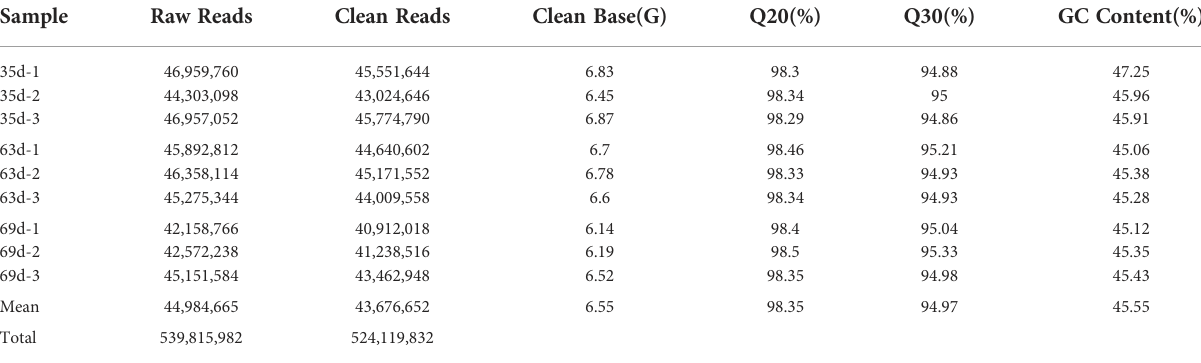
TABLE 1 Statistical results of the transcriptome sequencing of ‘ Feizixiao ’